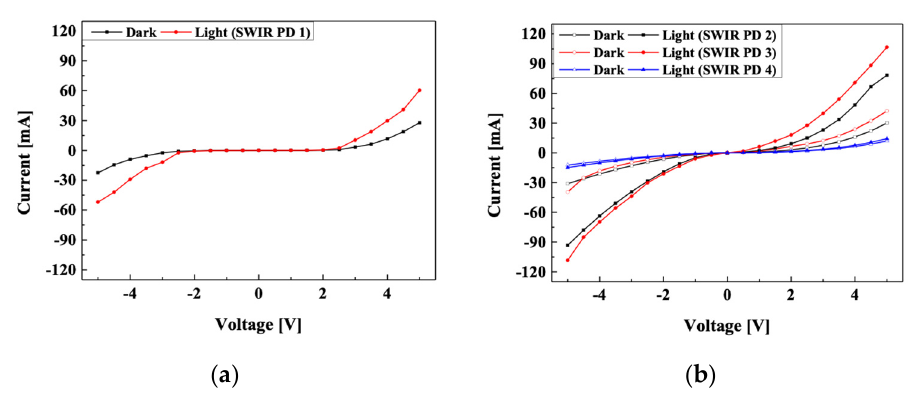
Figure 4. I-V characteristics of ( a ) PbS SWIR photodetector without P3HT (SWIR PD 1) and ( b ) PbS SWIR photodetector with P3HT (SWIR PD 2, 3, 4).